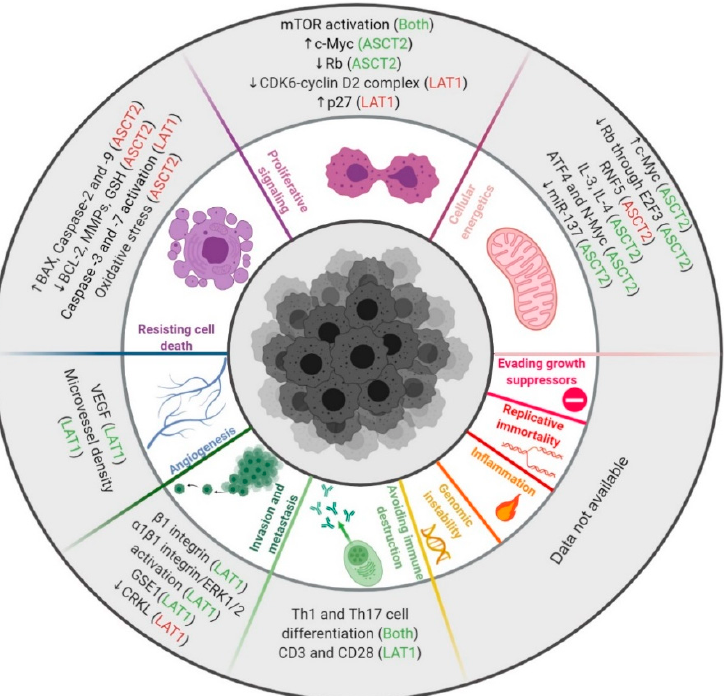
Figure 3. ASCT2, LAT1, and the hallmarks of cancer. Both ASCT2 and LAT1 have been associated with avoiding immune destruction [7,67–72] , invasion and metastasis [47,73–75] , angiogenesis [63,74,76–78] , resisting cell death [20,29,79–87] , proliferative signaling [43,52,87–99] , and cellular energetics [90,100–108] . The activation/overexpression (green) or inactivation/subexpression (red) of those molecules consequently results in the dysregulation of a variety of key players on those hallmarks of cancer, culminating in cancer. The role of ASCT2 and LAT1 in genomic instability and mutation, inflammation, replicative immortality, and evading growth suppressors remains to be explored (created with BioRender.com).